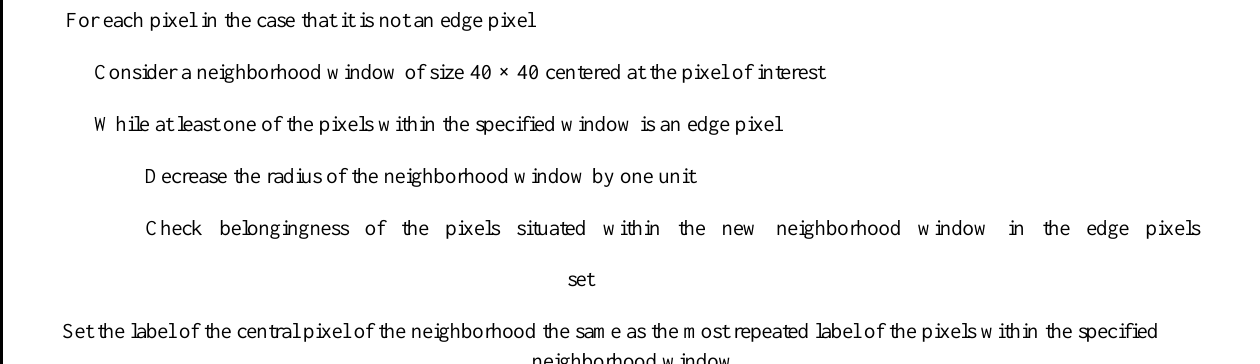
Figure 7. Flowchart of the post-processing